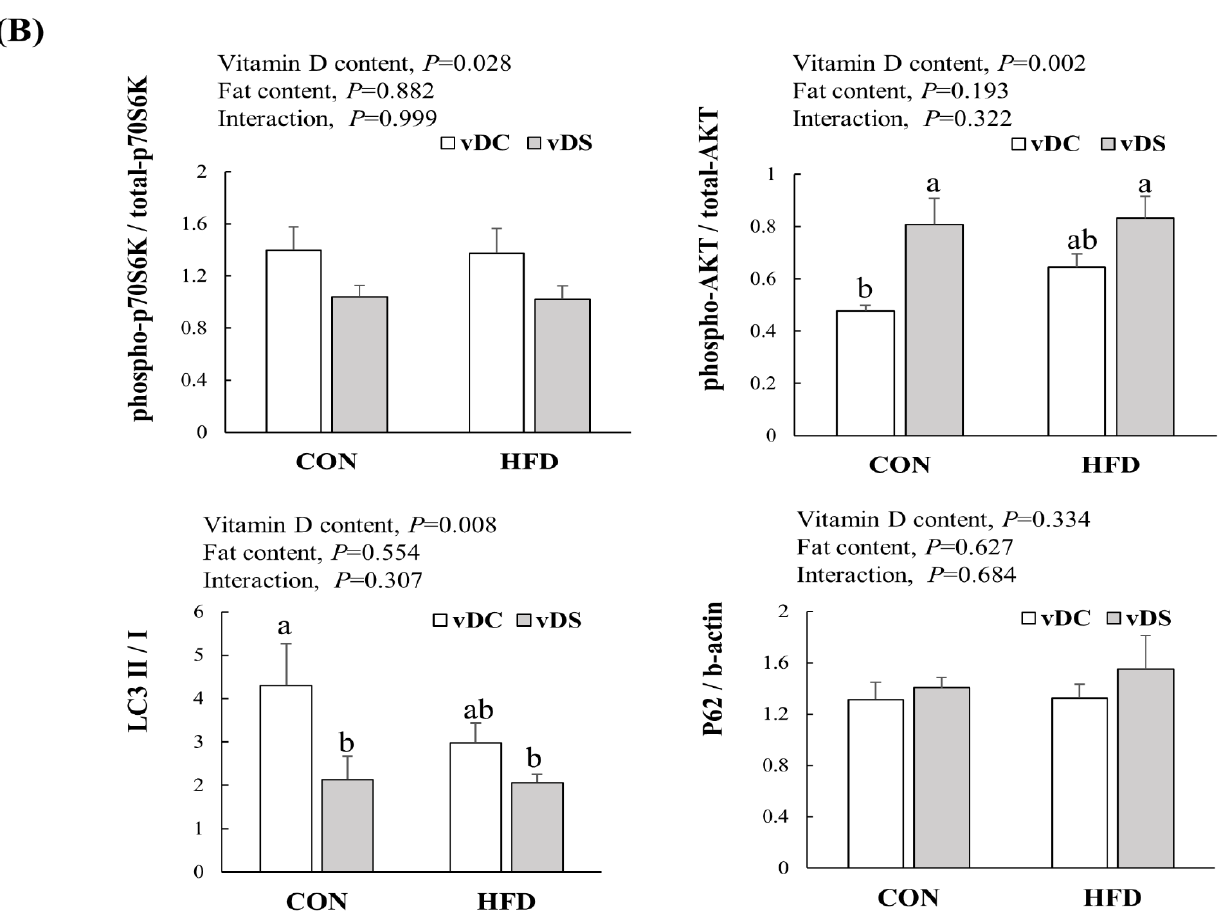
Figure 4. Levels of proteins related with mTOR pathway in T cells. Splenic T cells were stimulated with anti-CD3/anti-CD28 mAbs for 48 h, and the expression levels of p70S6K, AKT, LC3, and P62 were determined by Western blot. ( A ) Representative Immunoblots of mTOR pathway proteins. ( B ) Data are presented as means ± SEMs, n = 5 per group. Two-way ANOVA was used to determine the significant effects of fat and vitamin D contents, and an interaction. a,b Different superscripts indicate significant difference ( p < 0.05) among individual groups, by Fisher’s least significant difference multiple comparison test. CON-vDC, 10% kcal fat diet + vitamin D control; CON-vDS, 10% kcal fat diet + vitamin D supplemented; HFD-vDC, 45% kcal fat diet + vitamin D control; HFD-vDS, 45% kcal fat diet + vitamin D